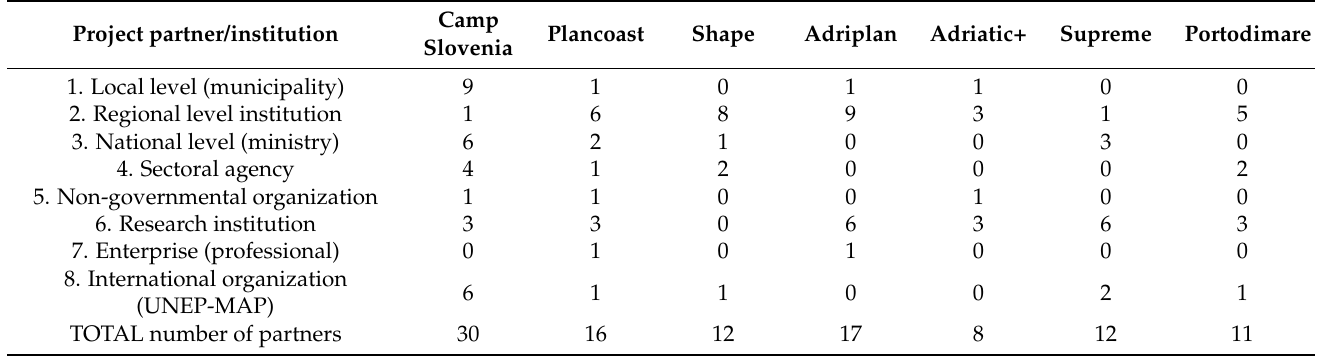
Table 11. Range of institutions of the participating countries in individual projects—synthesis presentation of the total number. Project partner/institution